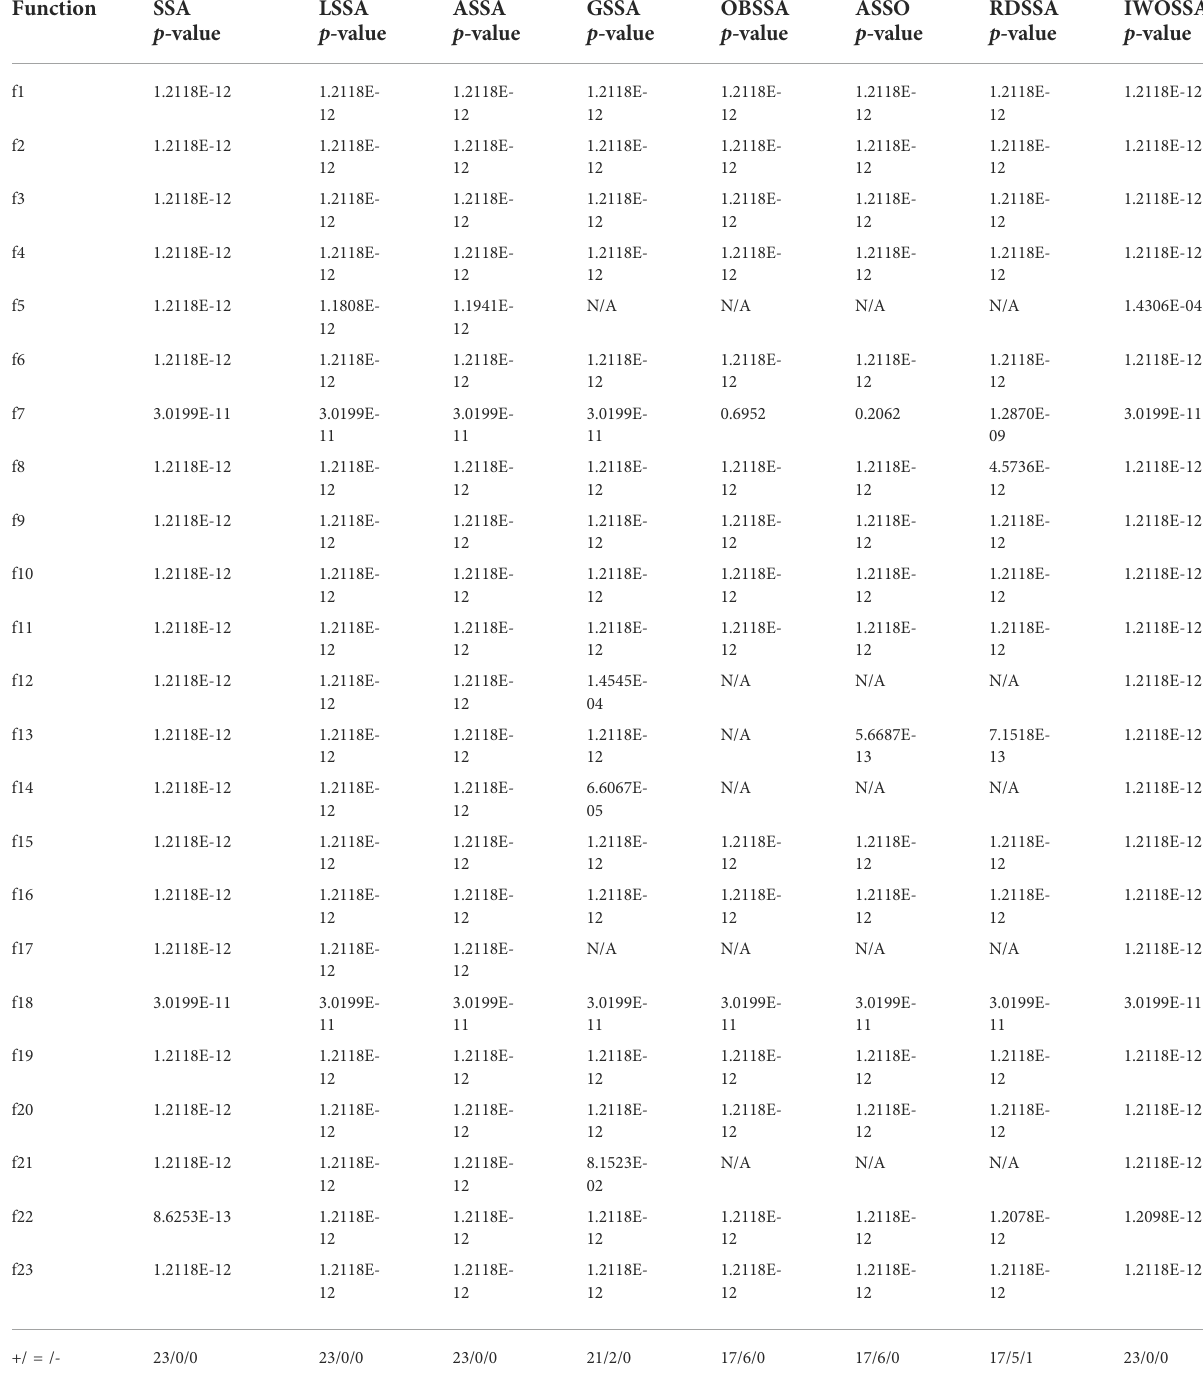
TABLE 4 Statistical conclusions based on Wilcoxon signed-rank test on 100-dimensional benchmark problems.